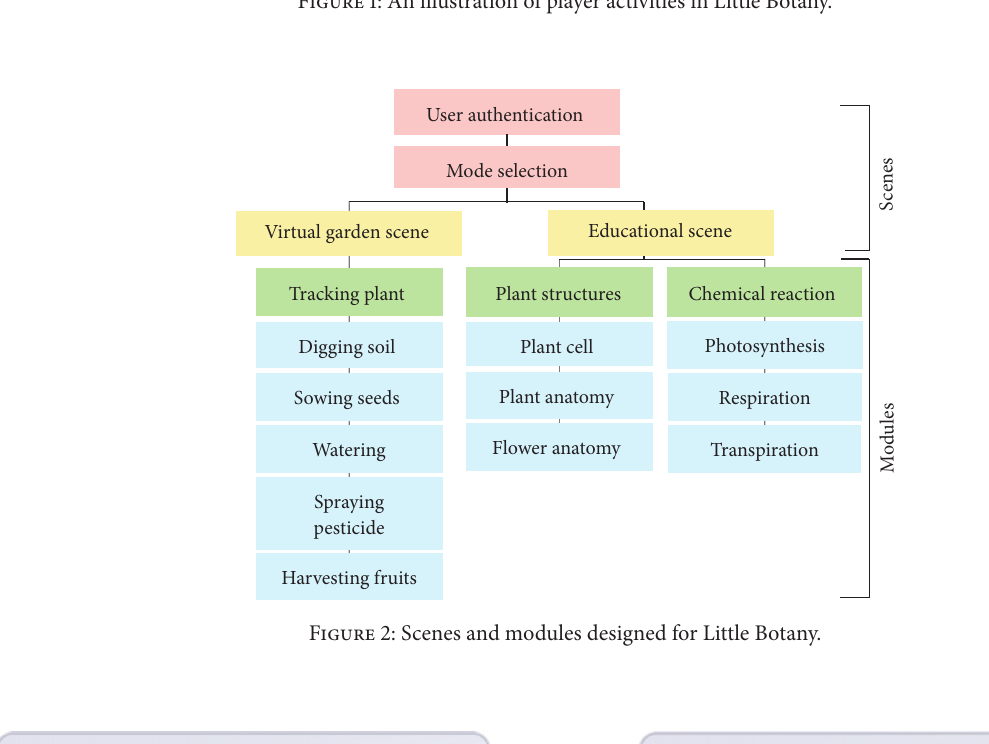
“Home” button in hard to reach area